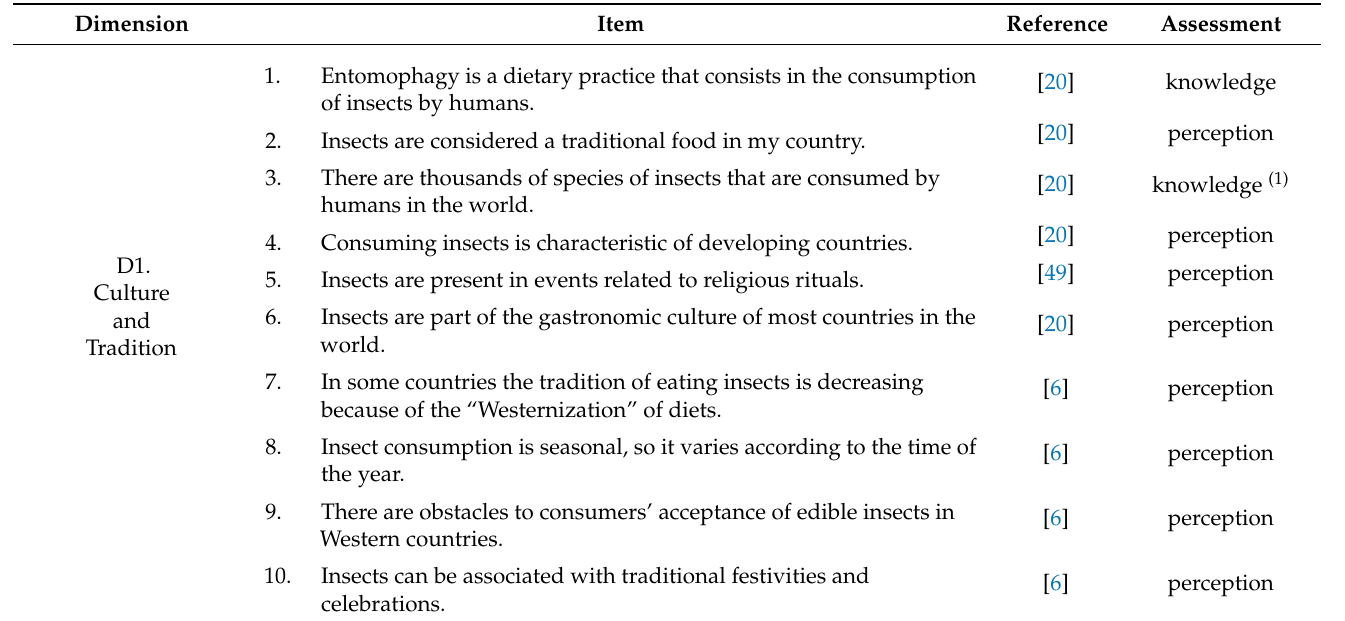
Table A1. Items that compose the questionnaire, in the final version. Dimension